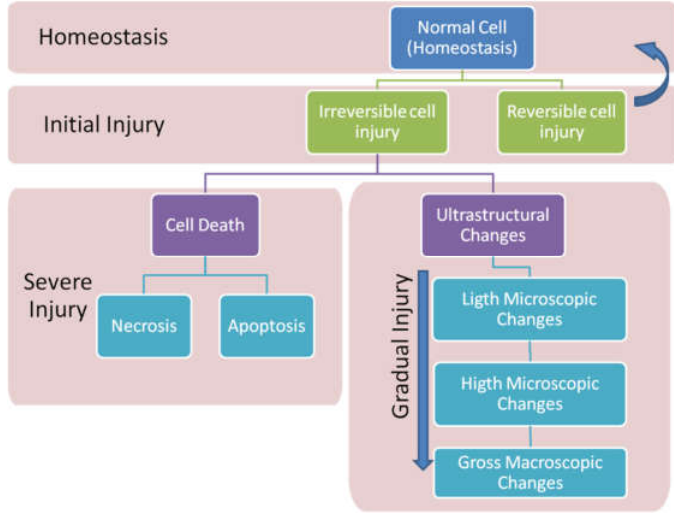
Figure 1. Cellular and tissue regeneration process after injury.